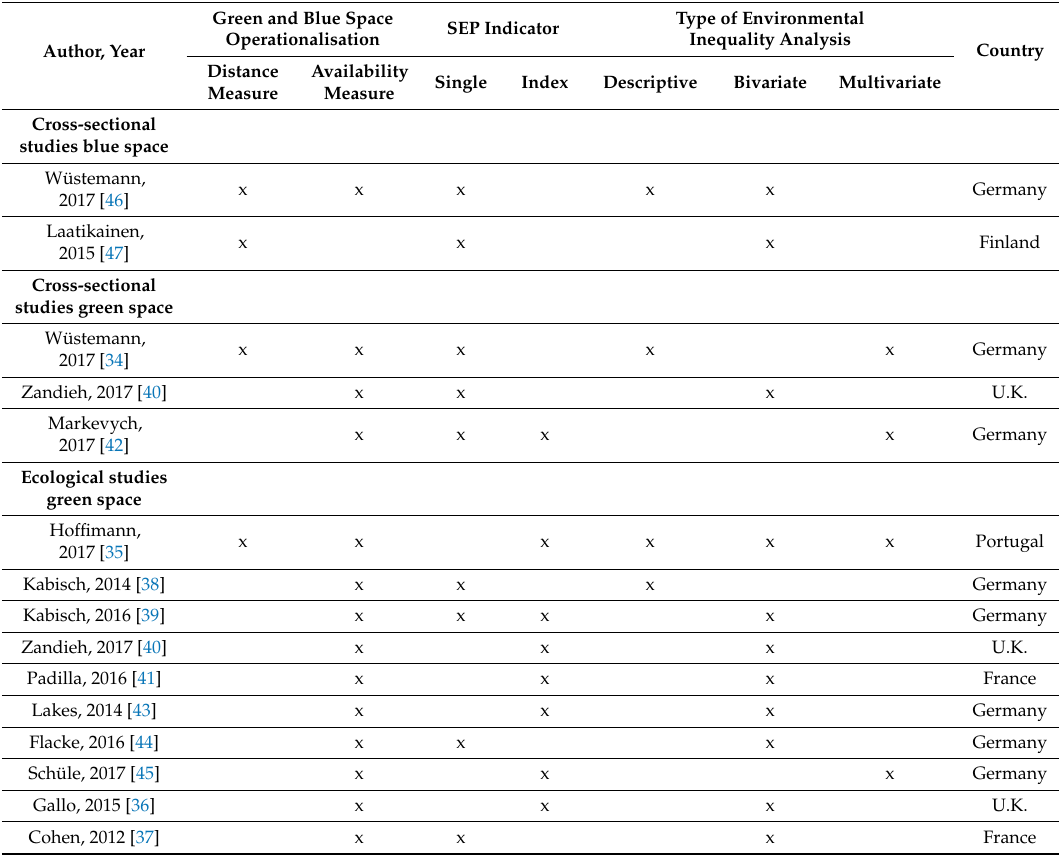
Table 2. Characteristics of